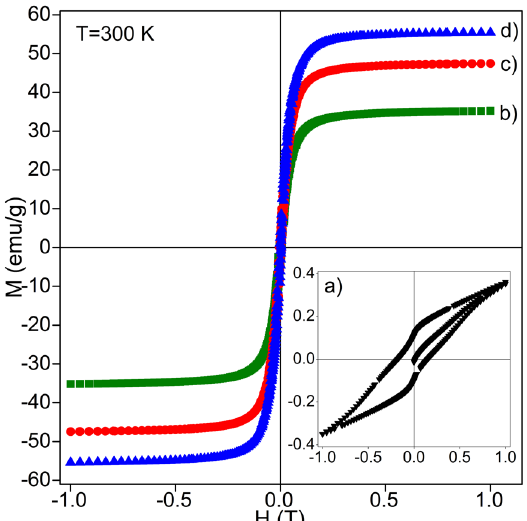
Figure 9. Hysteresis loops of (a) the initial mixture of reactants and of the samples submitted to heat treatments at (b) 1000 ºC, (c) 1100 ºC and (d) 1200 ºC.